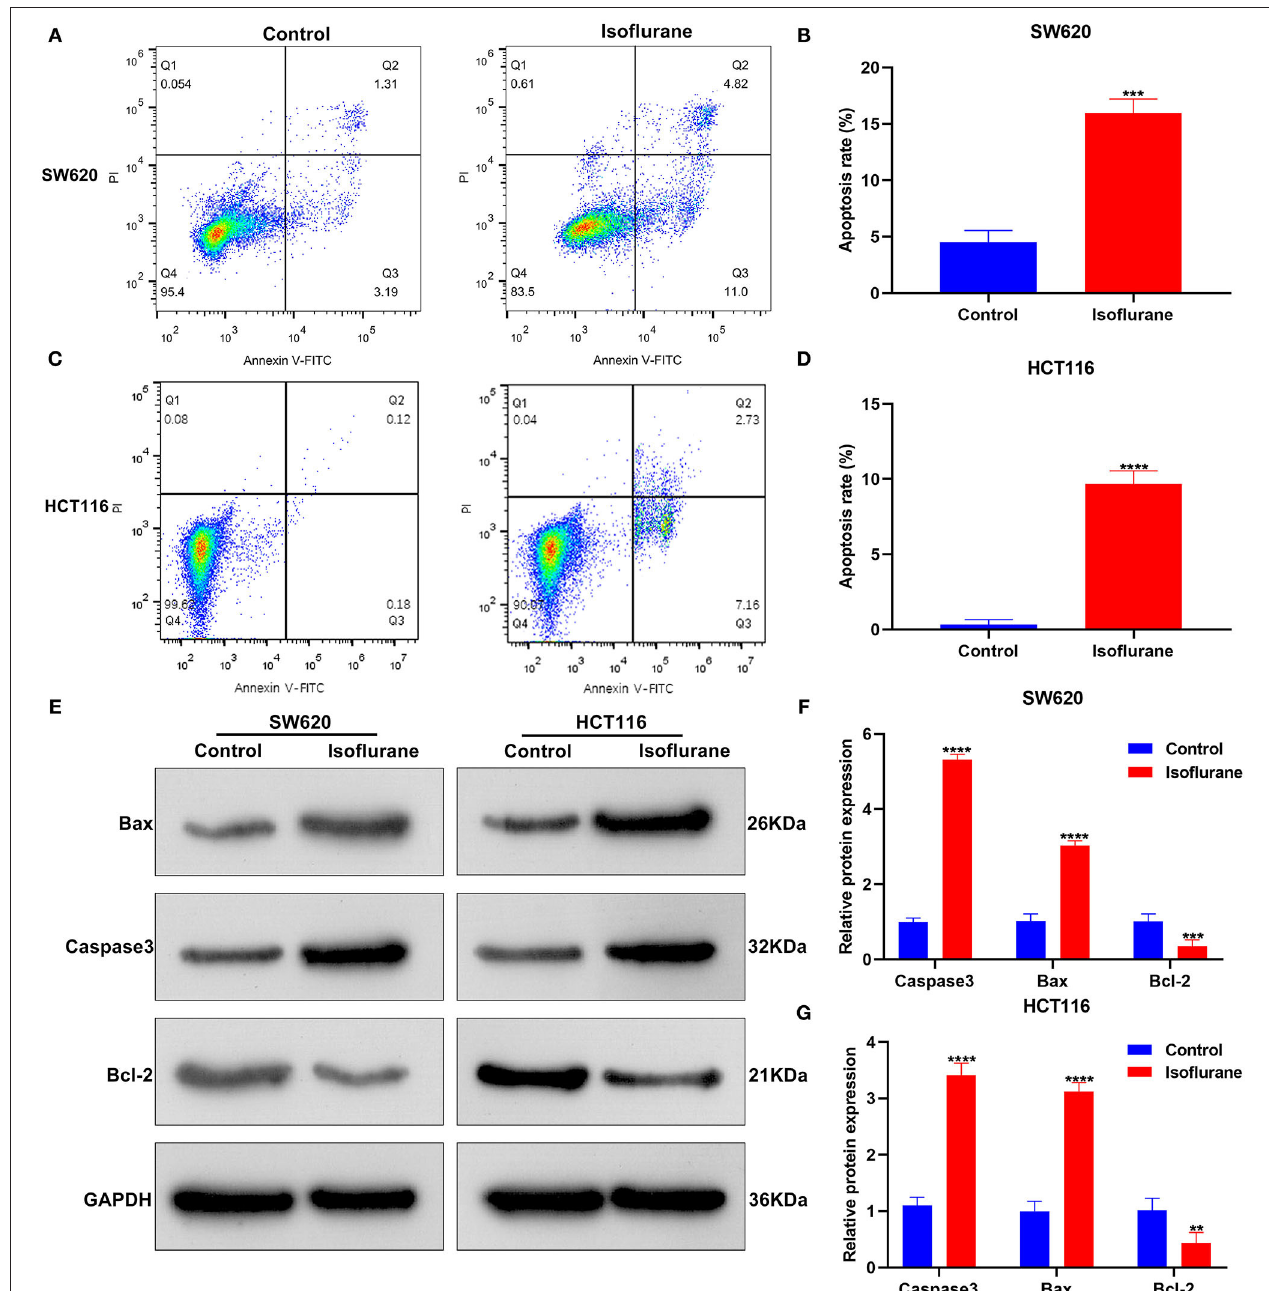
FIGURE 2 | The promotional effects of isoflurane on CRC cell apoptosis. Apoptosis rates of (A,B) SW620 and (C,D) HCT116 cells under treatment with 40 µ M isoflurane. (E–G) Expression of Caspase3, Bax and Bcl-2 proteins in SW620 and HCT116 cells following exposure to 40 µ M isoflurane. ** p < 0.01; *** p < 0.001; **** p <